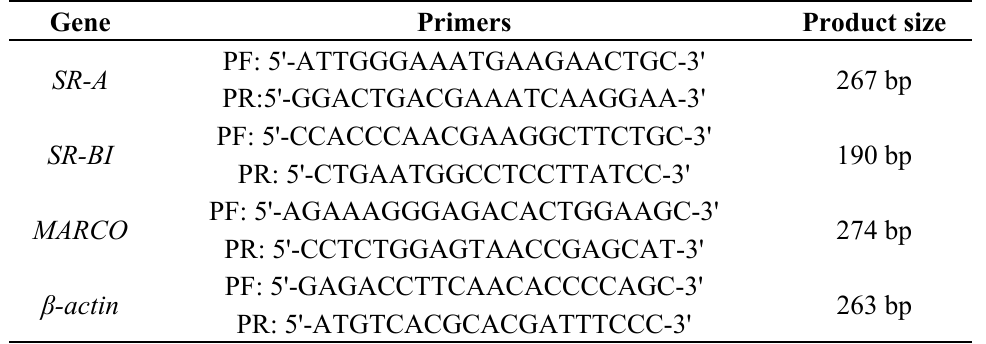
Table 1. Primers used for PCR analysis of gene